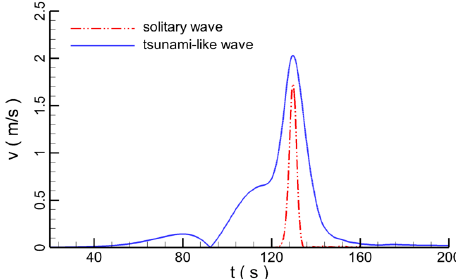
Figure 15. Time series of velocity at velocity sensor P during the tsunami-like wave and solitary wave.